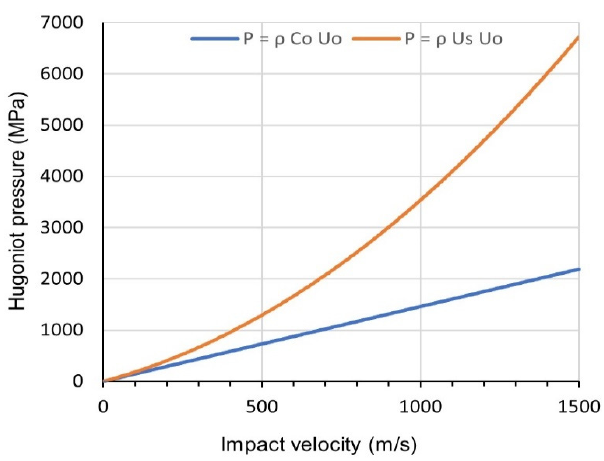
Figure 3. Effect of compressibility on the Hugoniot pressure for water. Adapted from Ref. [17].